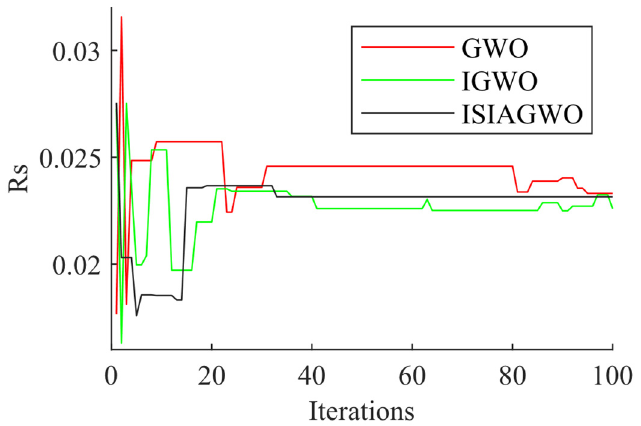
Figure 13. The stator resistance of DFIG identification convergence curve. The rotor resistance of DFIG identification convergence curve, shown in Figure 14.